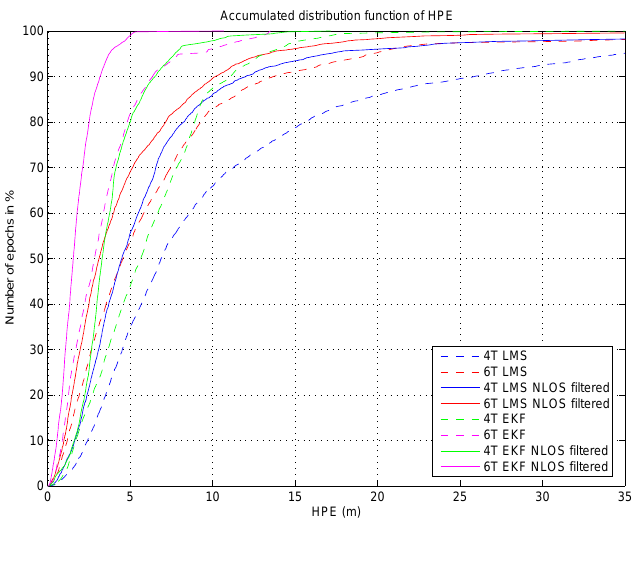
Figure 2. Cumulative distribution function of the horizontal position error